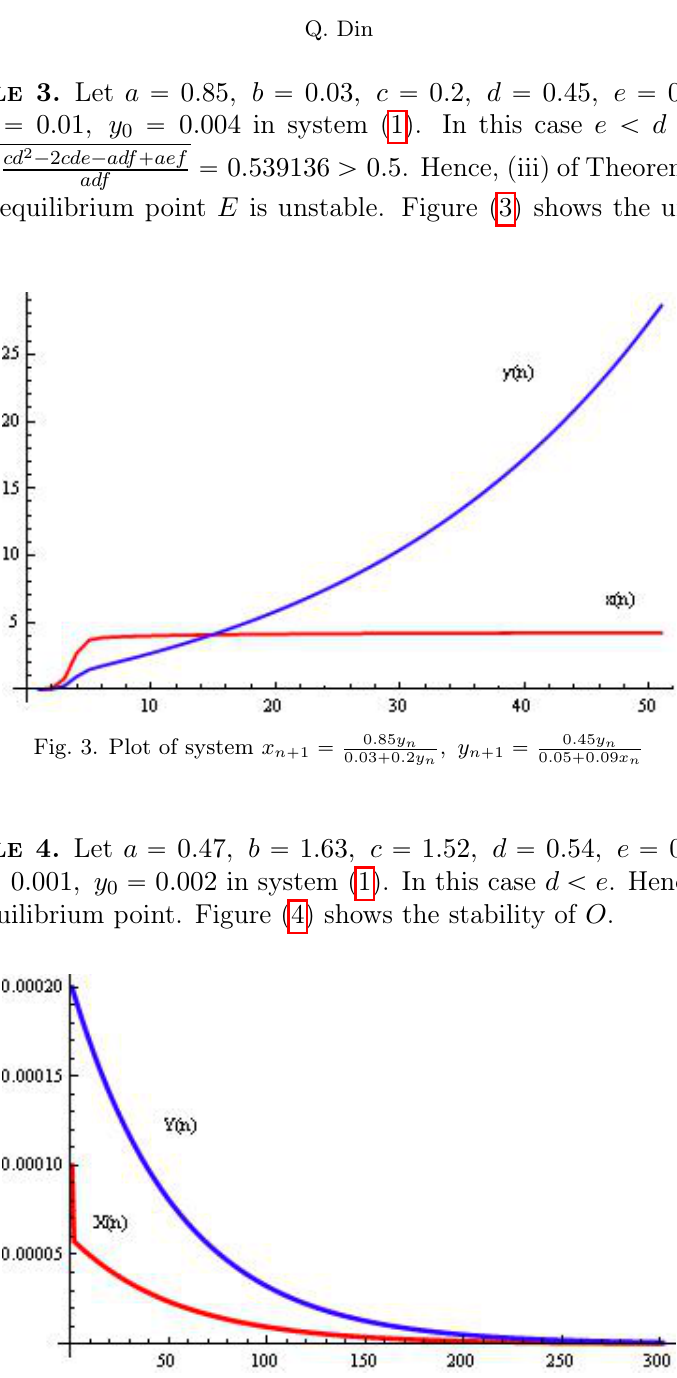
Fig. 4. Plot of system x n ` 1